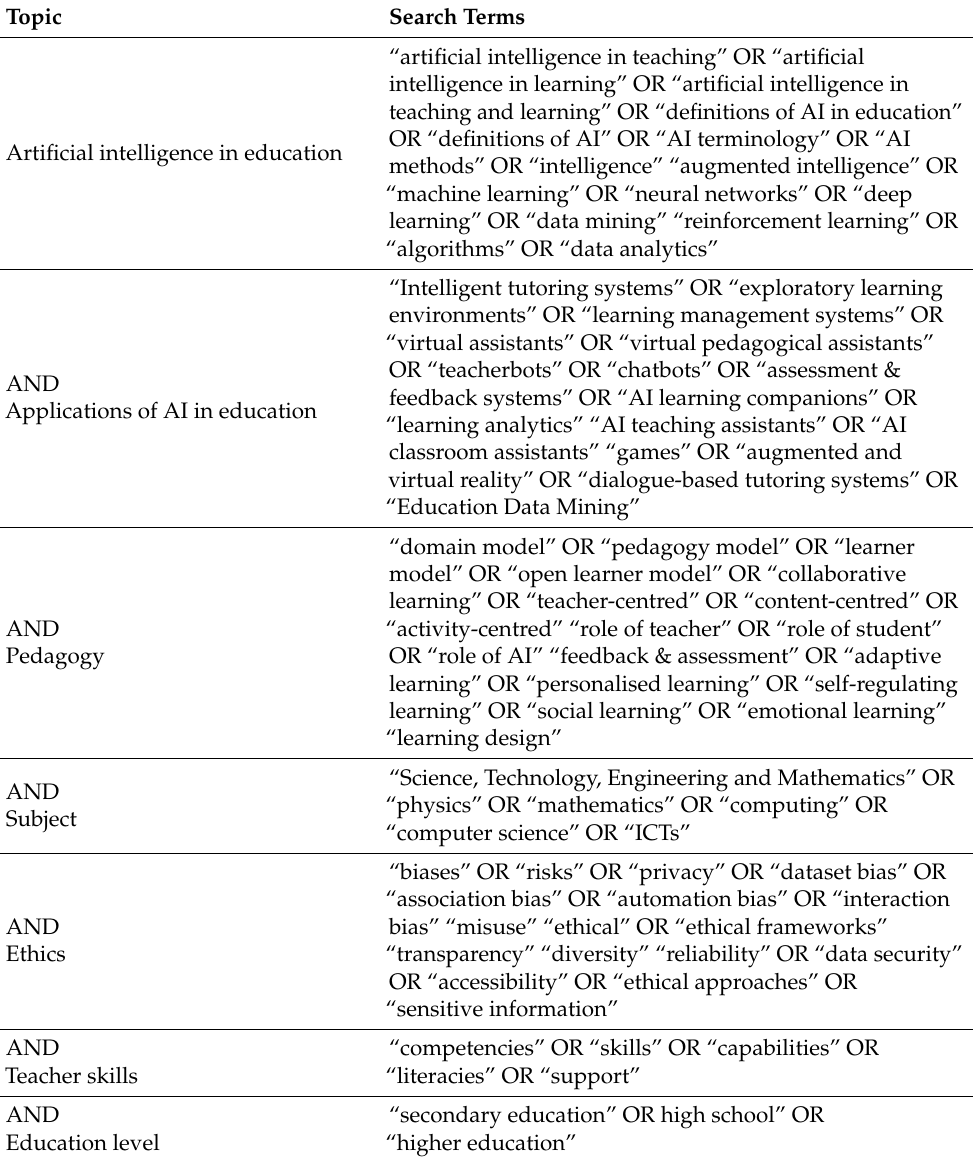
Table 1. Search terms and strings